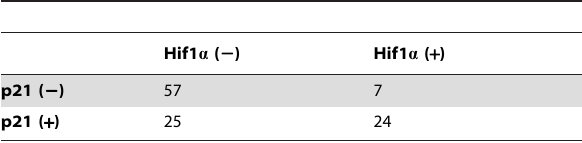
Table 2. Joint distribution of p21 and hif1 a in the study population.